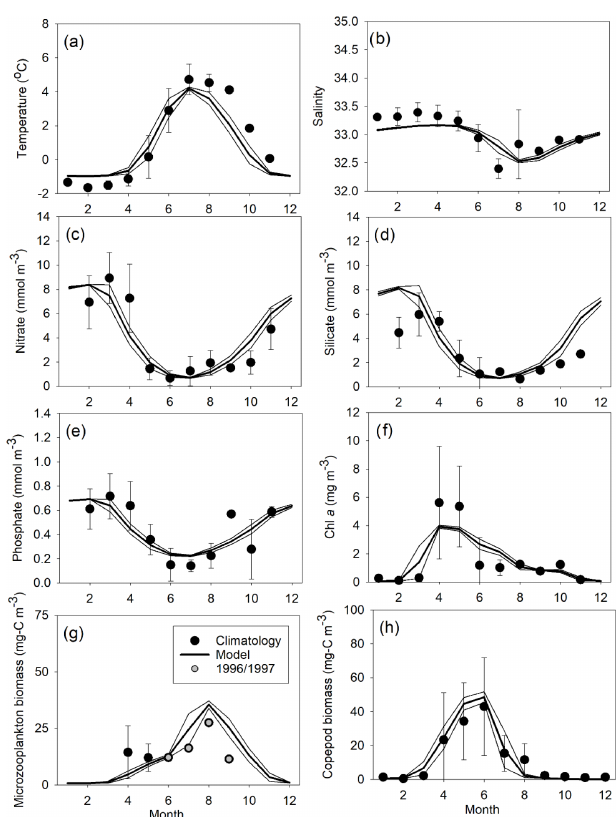
Figure 4. Comparison of monthly means ( ± SD) of observations and model data (2004–2018) at 69 ◦ 14 (cid:48) N, 53 ◦ 23 (cid:48) W for (a) tem- perature ( ◦ C), (b) salinity, (c) nitrate (mmolm − 3 ), (d) silicate (mmolm − 3 ), (e) phosphate (mmolm − 3 ), (f) Chl a (mgm − 3 ), (g) microzooplankton biomass (mgCm − 3 ), and (h) mesozooplank- ton biomass (mgCm − 3 ). Means are averaged over 0–20m depth, except for mesozooplankton, which is averaged over 0–50m.